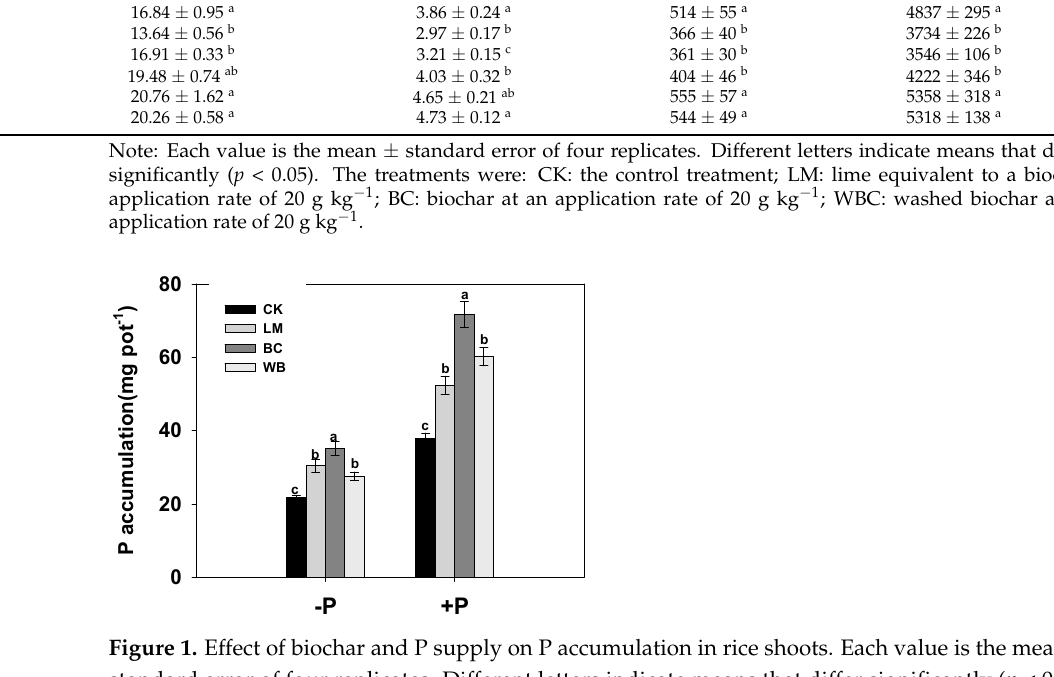
Table 5. Effect of biochar and P supply on the growth and root morphology of rice ( Oryza sativa L.) seedlings.